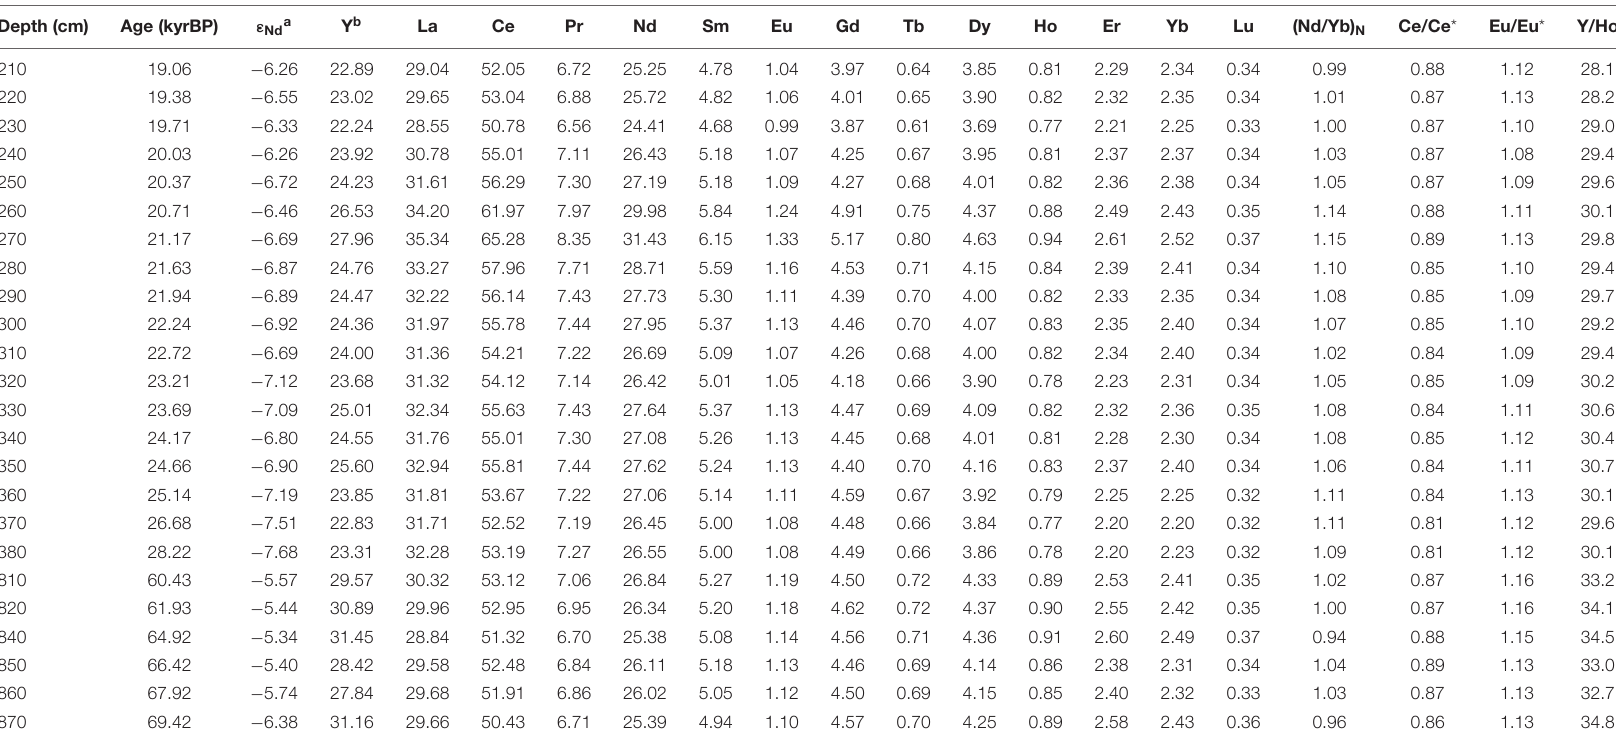
TABLE 4 | Rare earth element and Nd isotopic composition of fine-grained ( < 4 µ m) detrital fractions (core MD03-2607). Depth